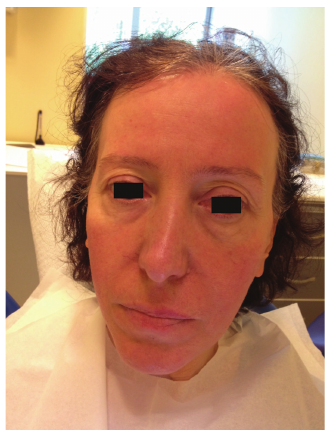
Figure 4: 10 days following the incident the patient became asymp-